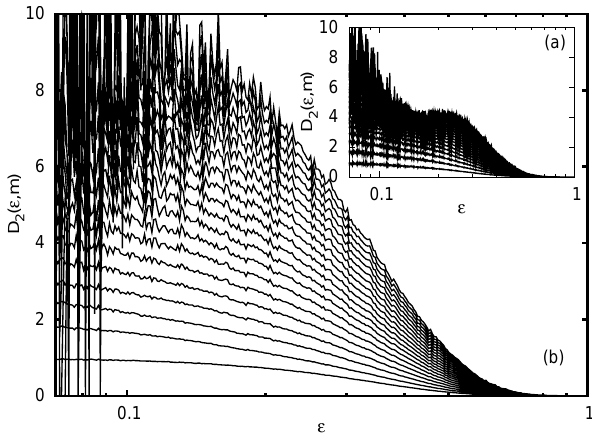
Fig. 10. The curve of S(1n) for the embedding dimensions m = 14 , 15 , 16 with τ = 1 ,ω = 25 . The maximum Lyapunov exponent λ of the detrended time series is the slope of the dashed line 0 . 0265 ± 0 . 0008.